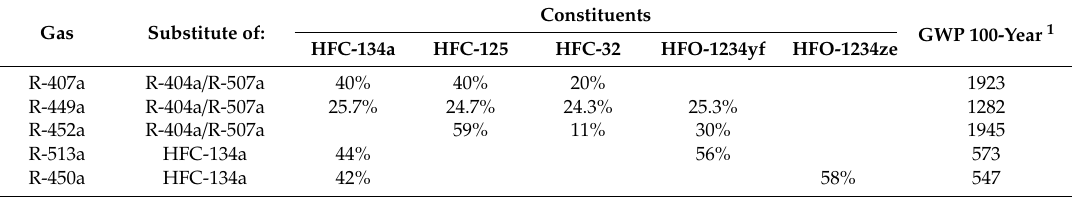
Table 2. Overview of mostly widely used replacement mixtures in the Czech Republic [23]. Gas Substitute